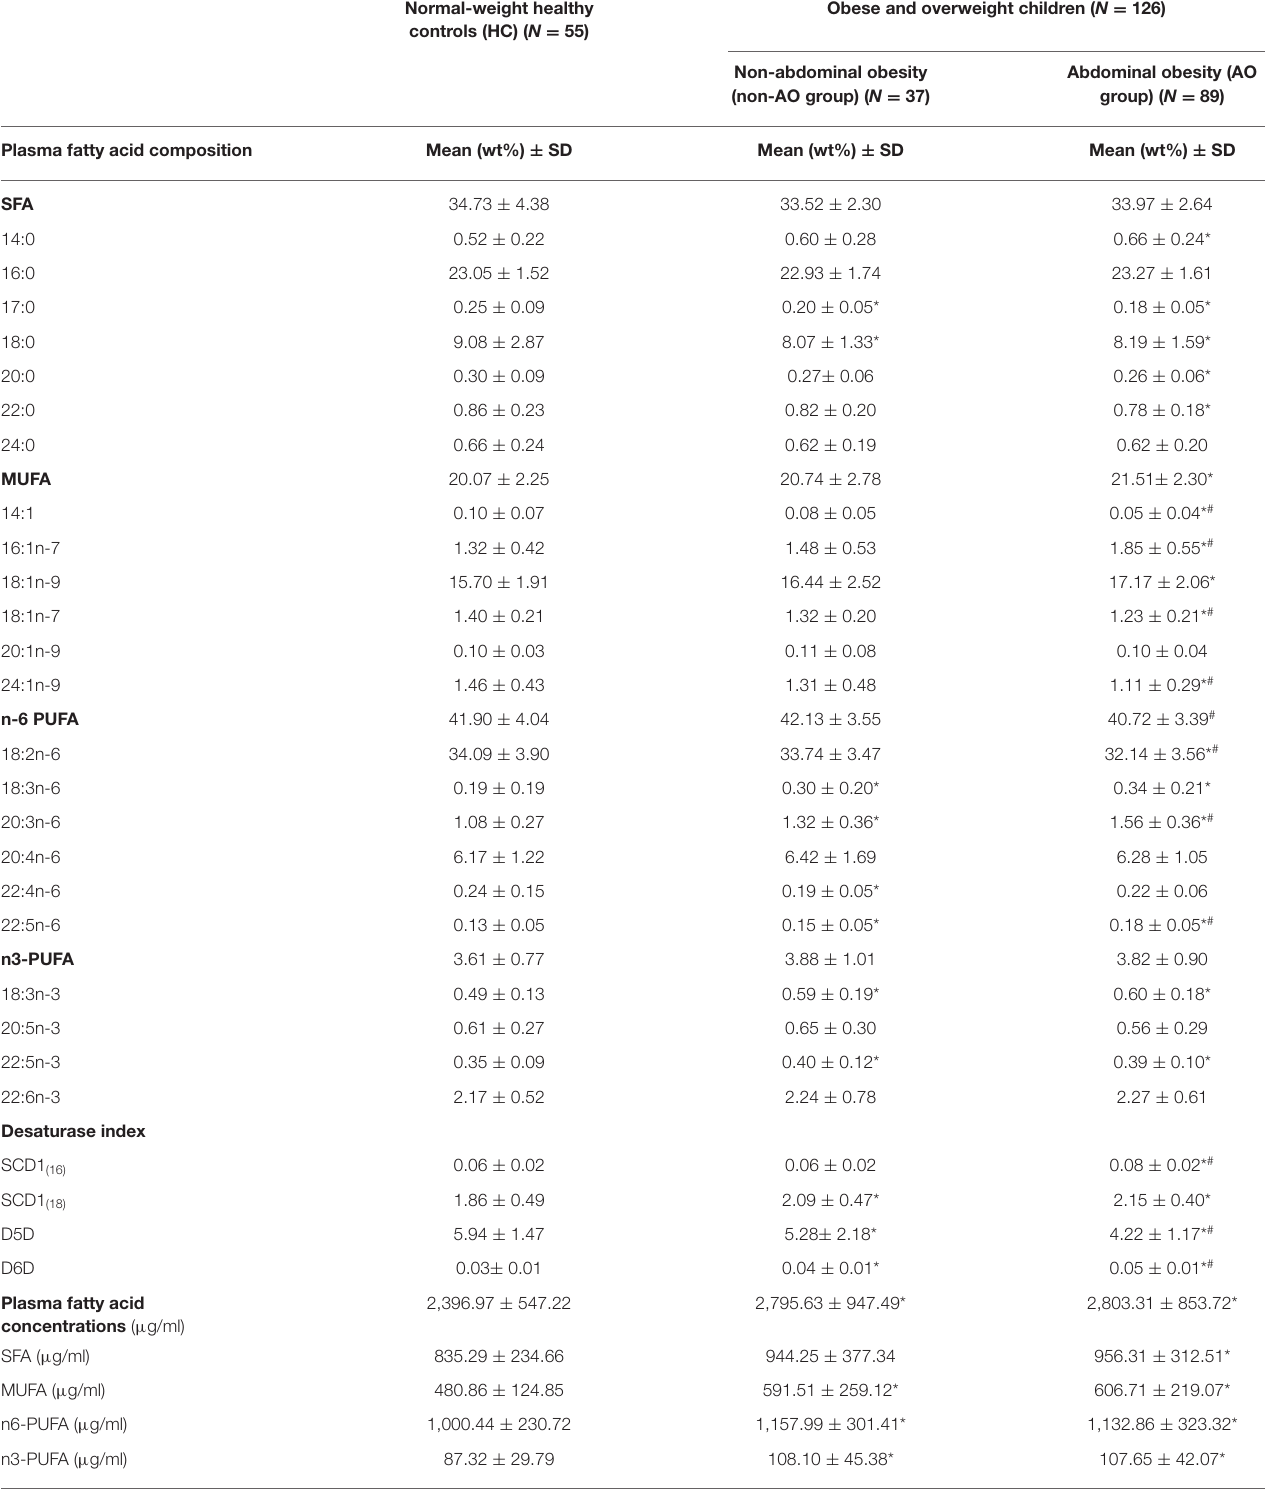
TABLE 2 | Plasma fatty acid profile and estimated desaturase activities with regard to body weight status and abdominal obesity.